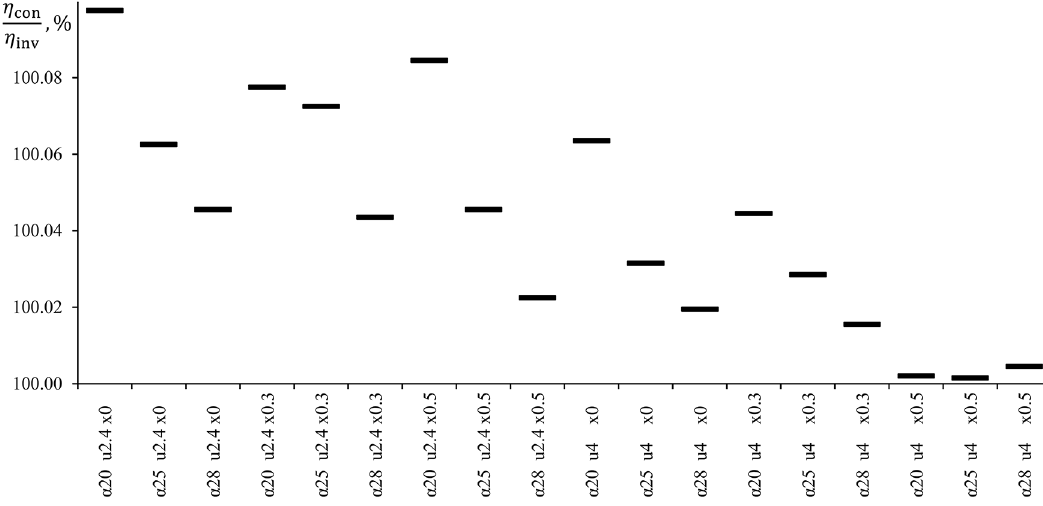
Fig. 4. Ratio between energy ef fi ciencies h con and h inv .